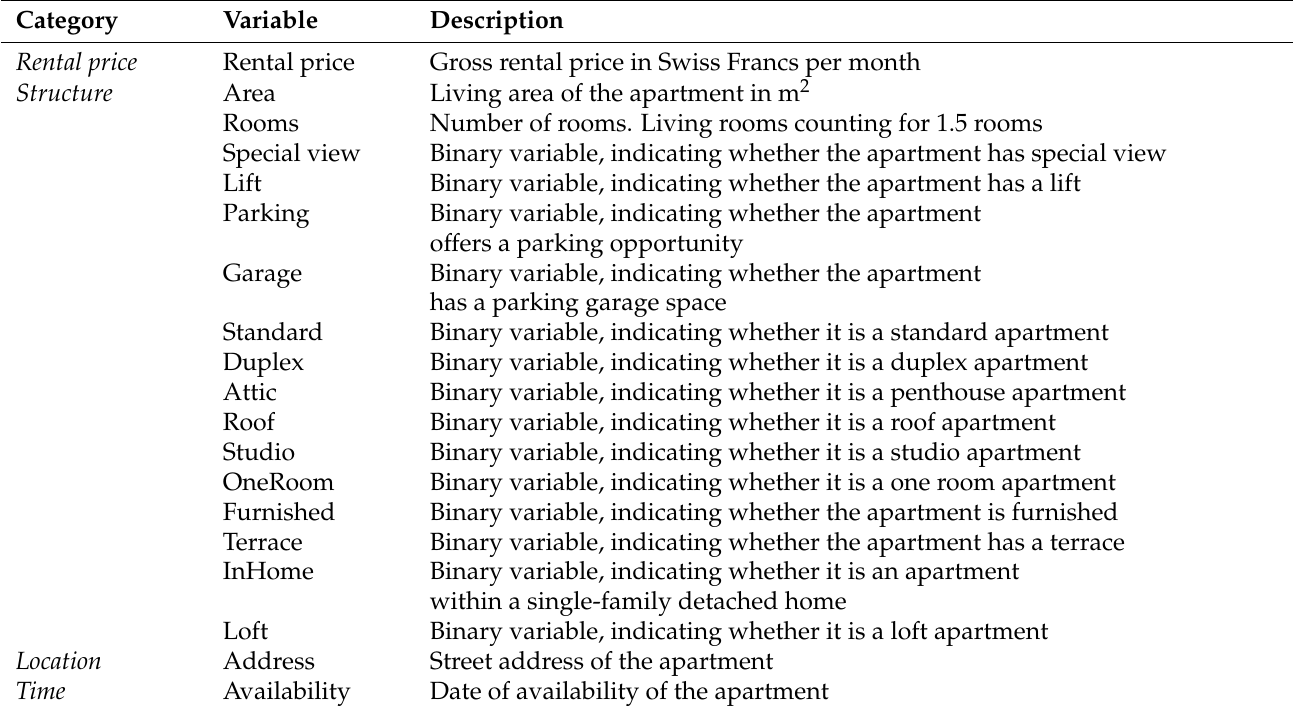
Table A1. Data description. (This table lists the apartment characteristics of rental dwellings by category, i.e., by rental price, structure, location, and time. The data set contains 49,501 observations provided by a multiple listing service for apartment offerings in the canton of Zurich from 2002 to 2014.)